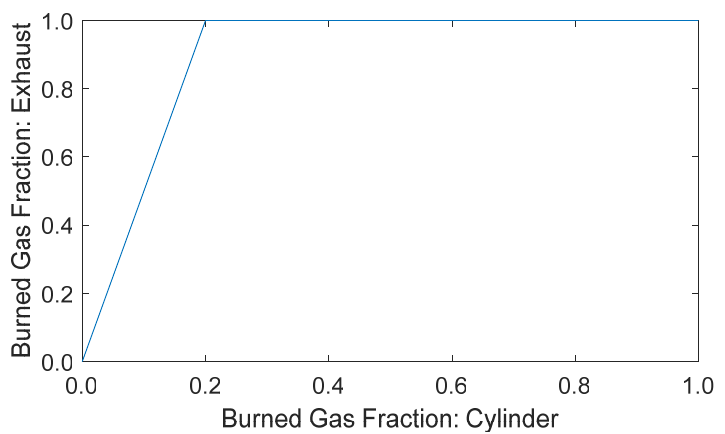
Figure 2. Scavenge profile based on 3D CFD predictions by Mattarelli et al. [35] (Figure 13).